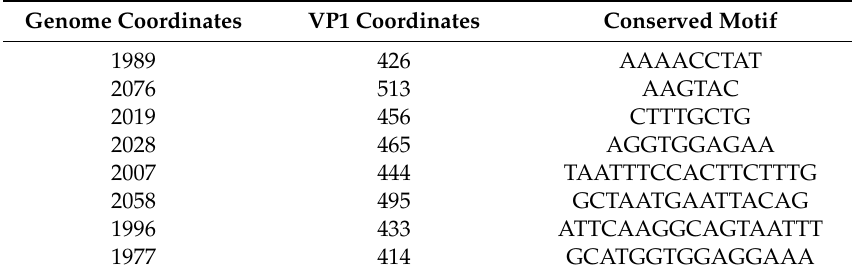
Table 2. BKTGR coordinates correspondence and its specific motifs. Genome coordinates are based on polyoma BK Dunlop strain (V01108.1) reference. VP1 coordinates correspond to nucleotide coordinates of the same reference using the first base of the gene as a starting position. The conserved motif corresponds to the motif used to transport coordinates from the reference to the query sequence (first nucleotide of the motif). Genome Coordinates VP1 Coordinates Conserved